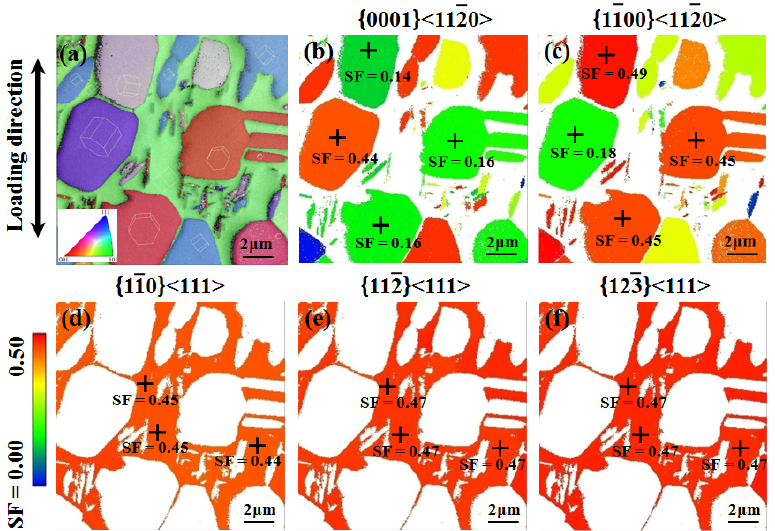
Figure 15. EBSD images of bimodal microstructure before stretching in situ; ( a ) inverse pole-figure (IPF) map; ( b ) SF map of α for basal slip; ( c ) SF map of α for prismatic slip; ( d ) SF map of β for {1 − 10}<111> slip; ( e ) SF map of β for {11 − 2}<111> slip; ( f ) SF map of β for {12 − 3}<111> slip.